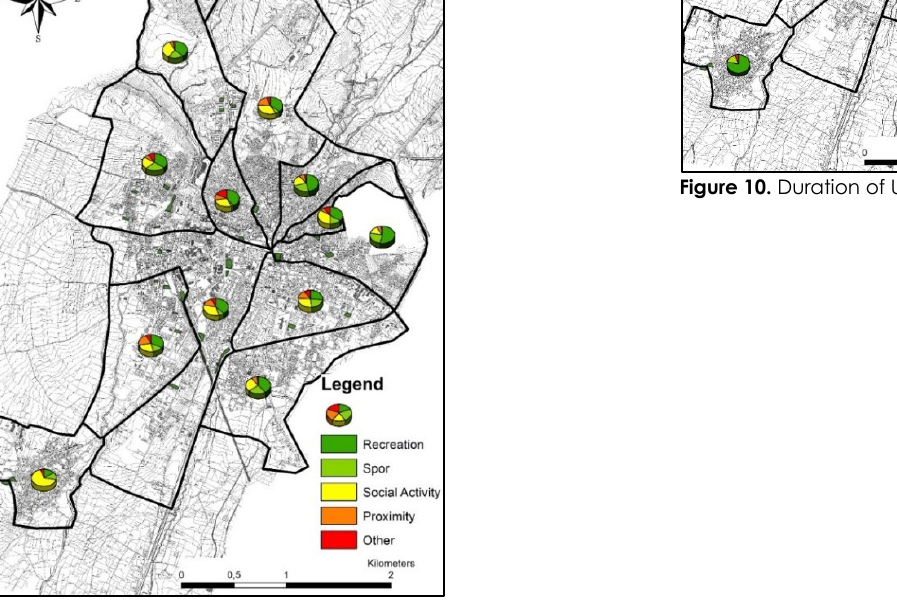
Figure 9. Urban Green Areas Usage.